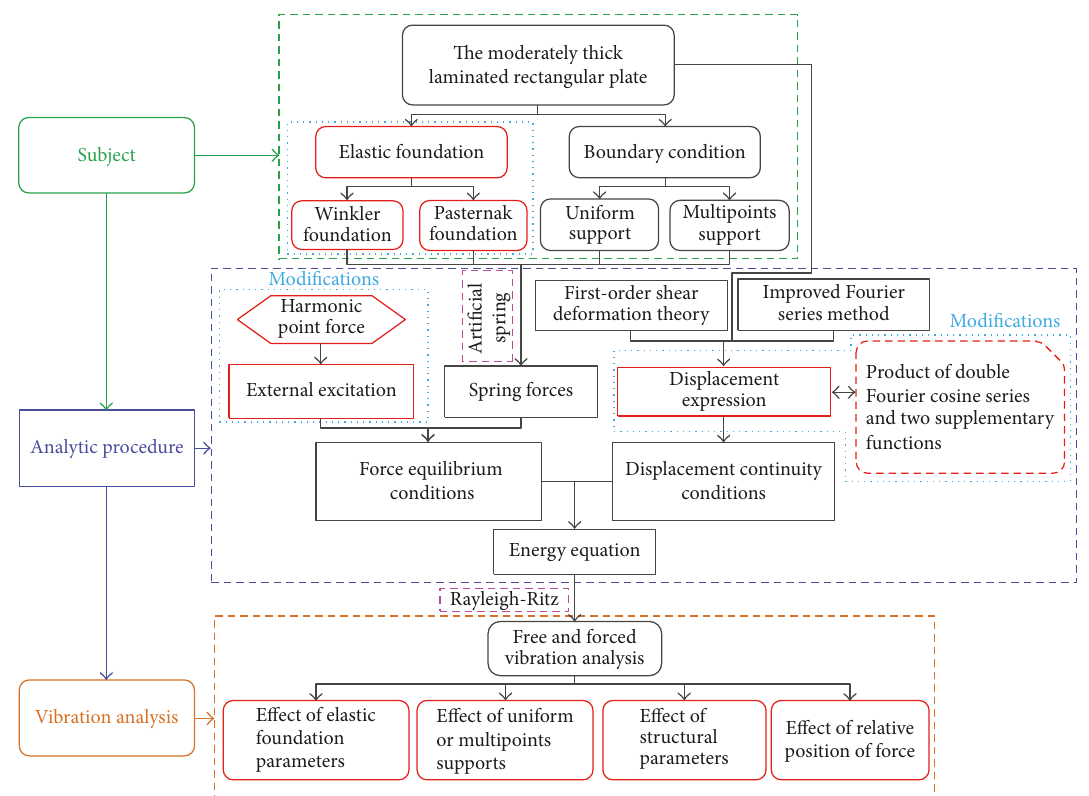
Figure 3: The flowchart about the solution for the laminated plate on the elastic